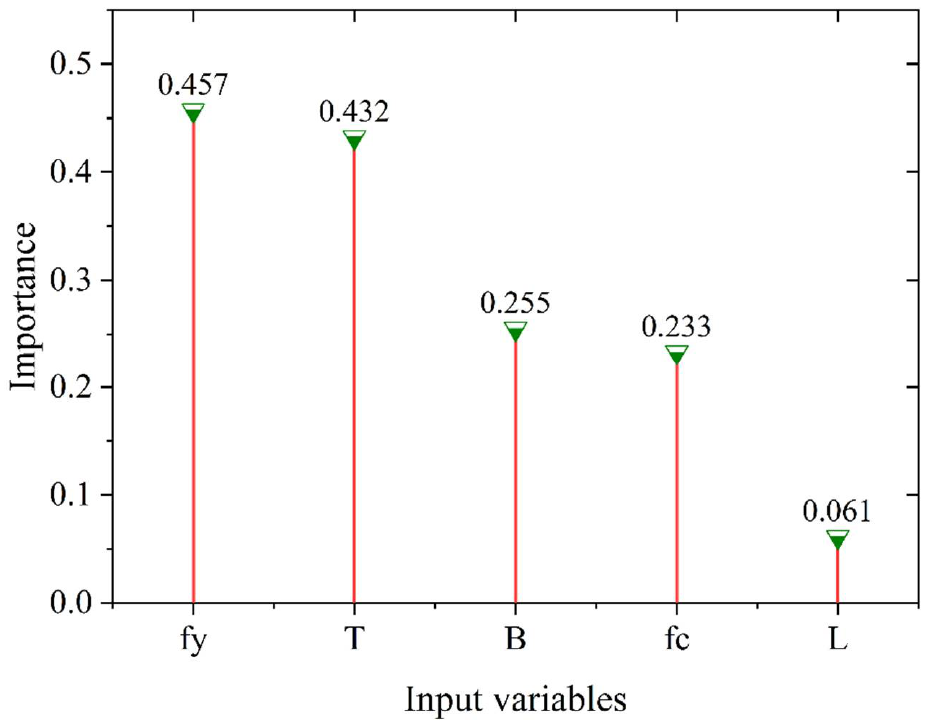
Figure 16. Importance of input variables.